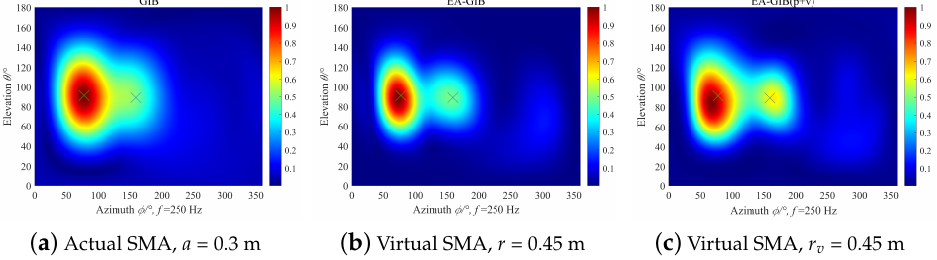
Figure 12. Experiment data processing results of the double sound source with the frequency 250